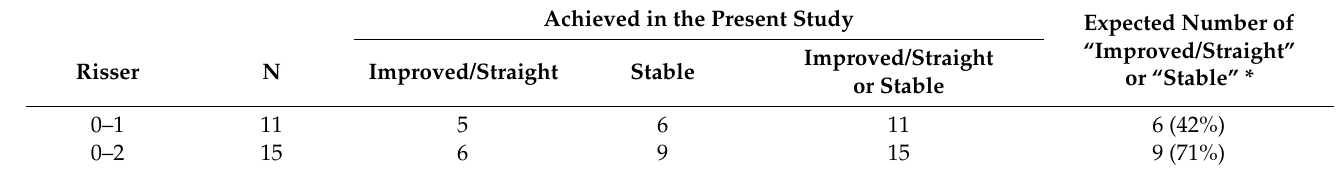
Figure 5. Average changes in Cobb’s angle (±one standard deviation) over time in the follow-up from the brace initiation to the long-term follow-up. (Upper-A). Table 2. The achieved and expected outcomes after using the soft brace at skeletal maturity. * expected outcome in accordance to Costa et al. (2021) [13] (Lower-B).